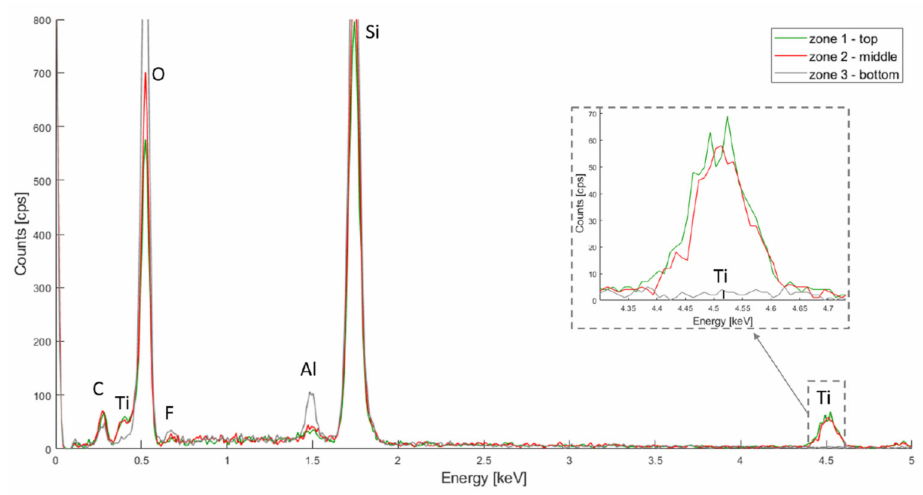
Figure 5. PSiO 2 /TiO 2 EDX spectra for the top, middle and bottom of the porous membrane.